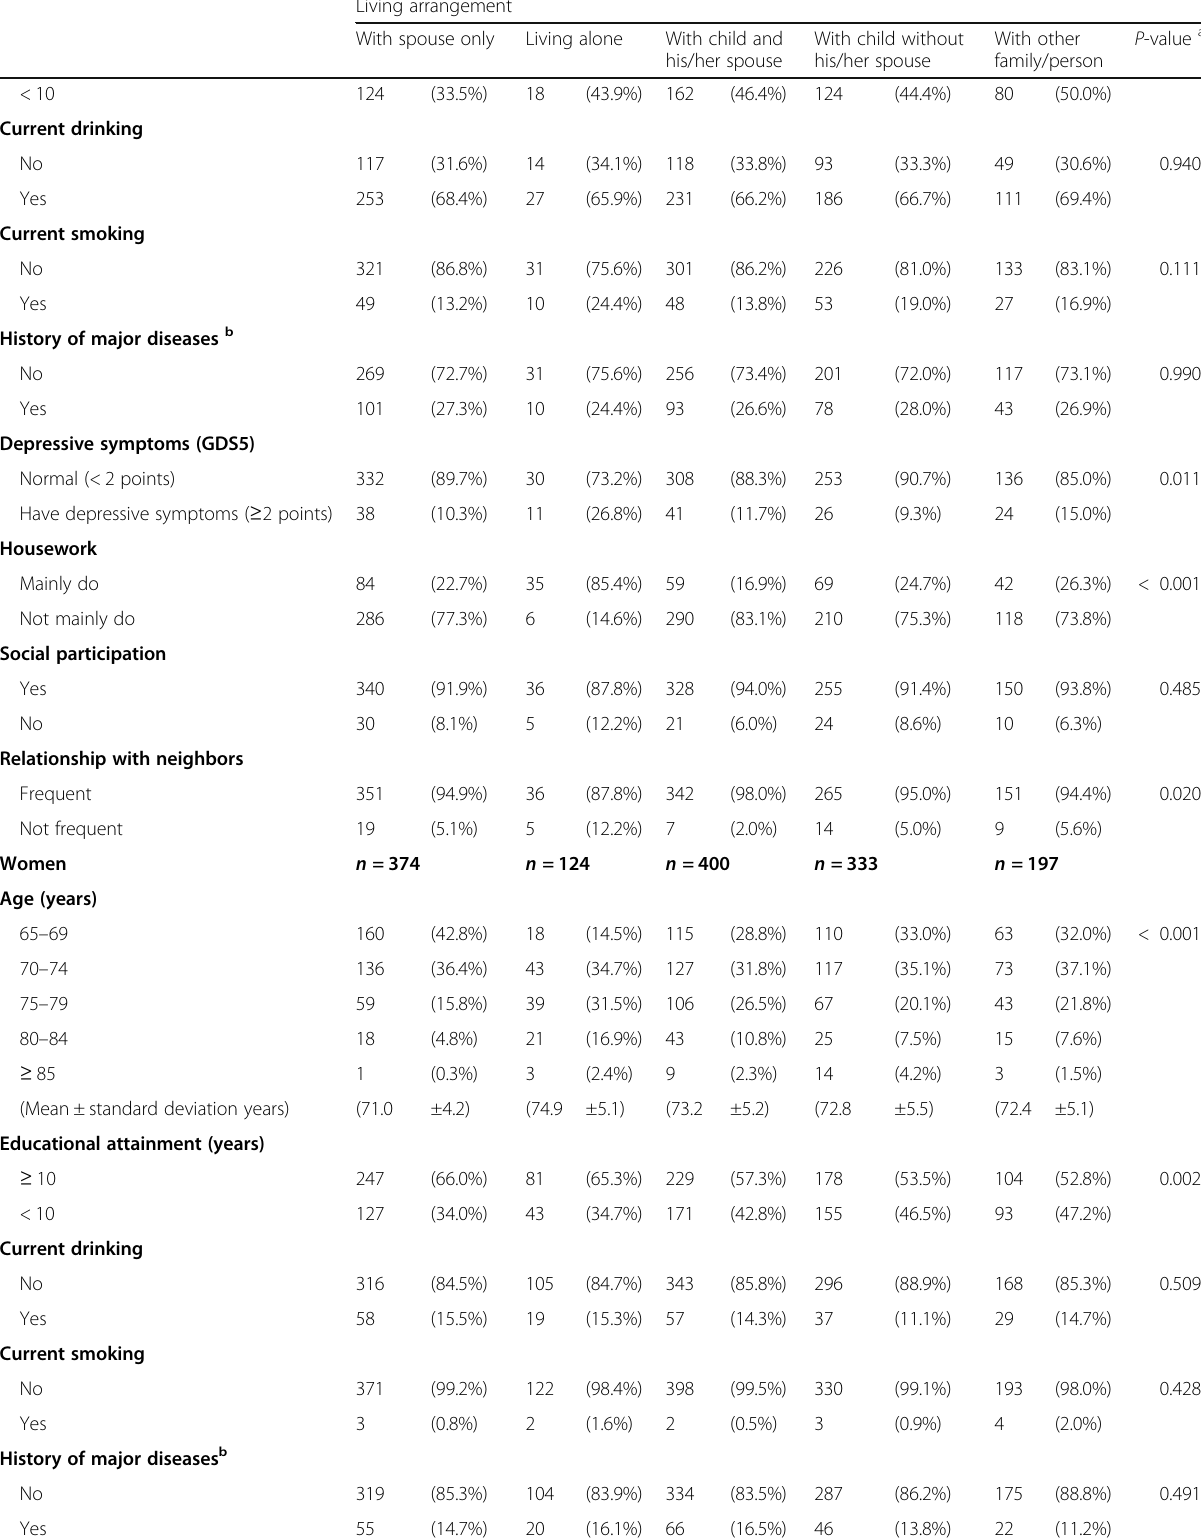
Table 1 Characteristics of the study population at baseline